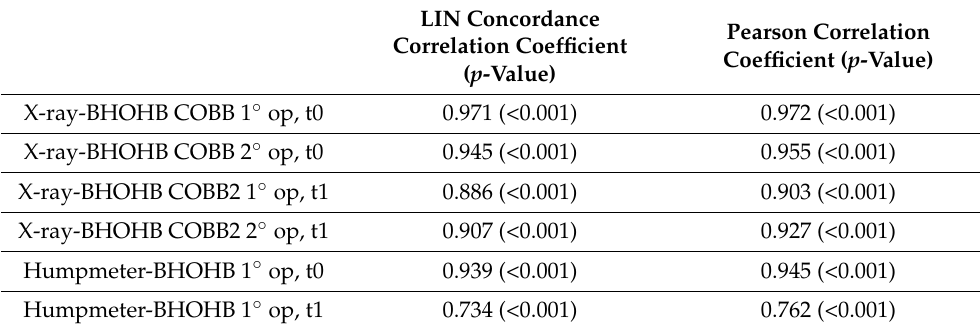
Table 1. Correlation between X-ray, humpmeter, and BHOHB.